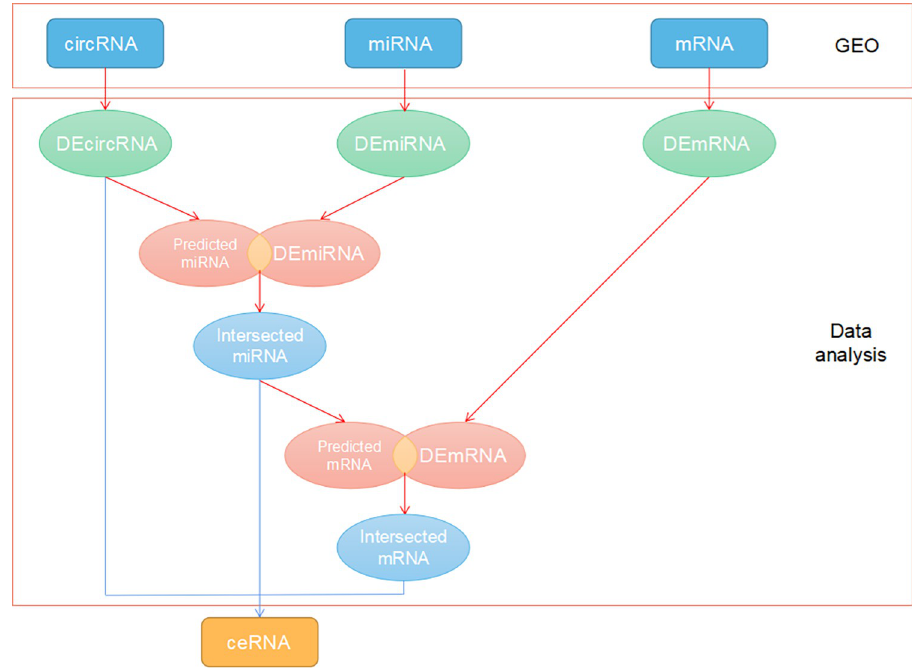
Fig 1. Ideas and flow chart of the entire